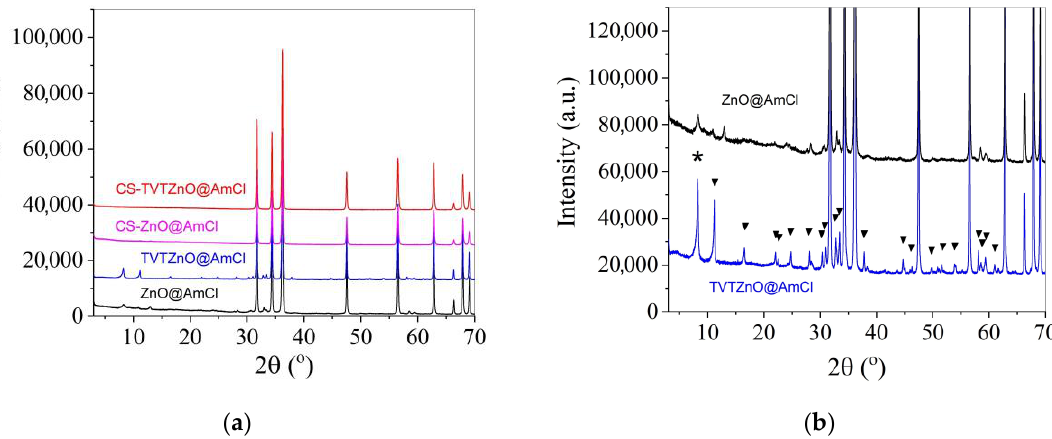
Figure 6. XRD patterns of powders ( a ) activated with 3% AmCl additive and obtained samples of 229